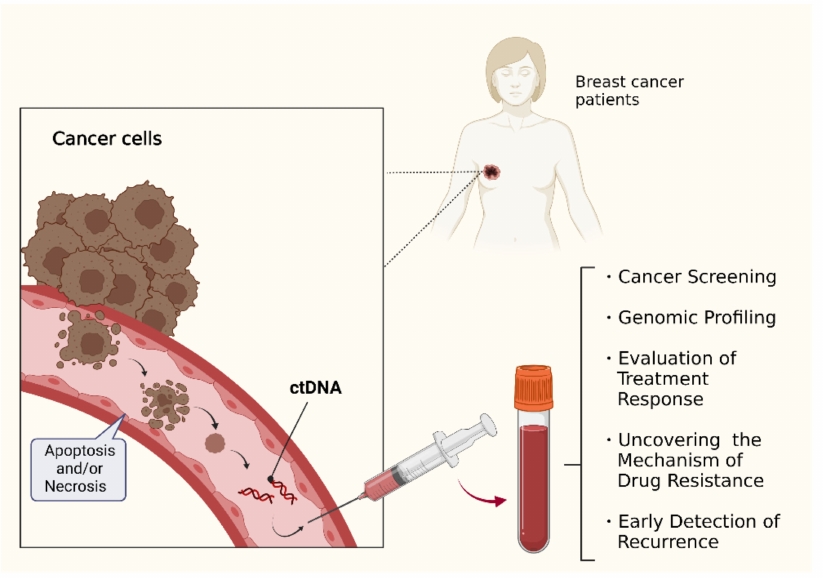
Figure 1. ctDNA and its utility. ctDNA is expected to be useful in various situations of cancer care including diagnosis, treatment, and recurrence. (Created with BioRender.com, 31 October